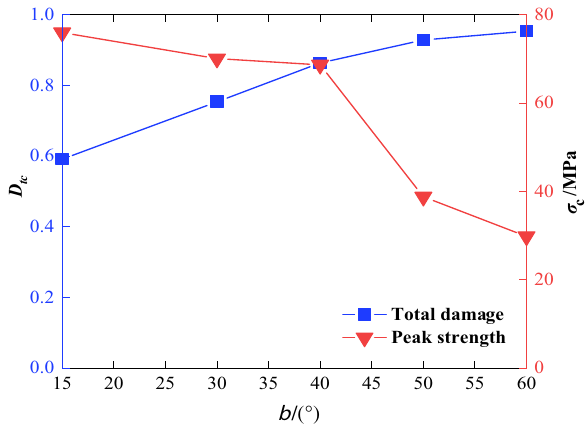
Figure 7. Relations among the peak strength, total damage value and joint dip